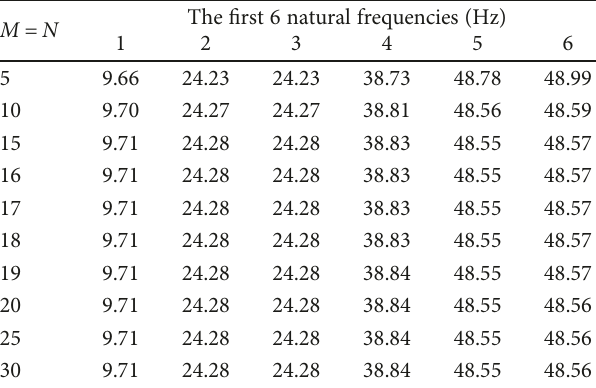
Table 2: Frequencies for S-S-S-S square panel with di ff erent truncate numbers.